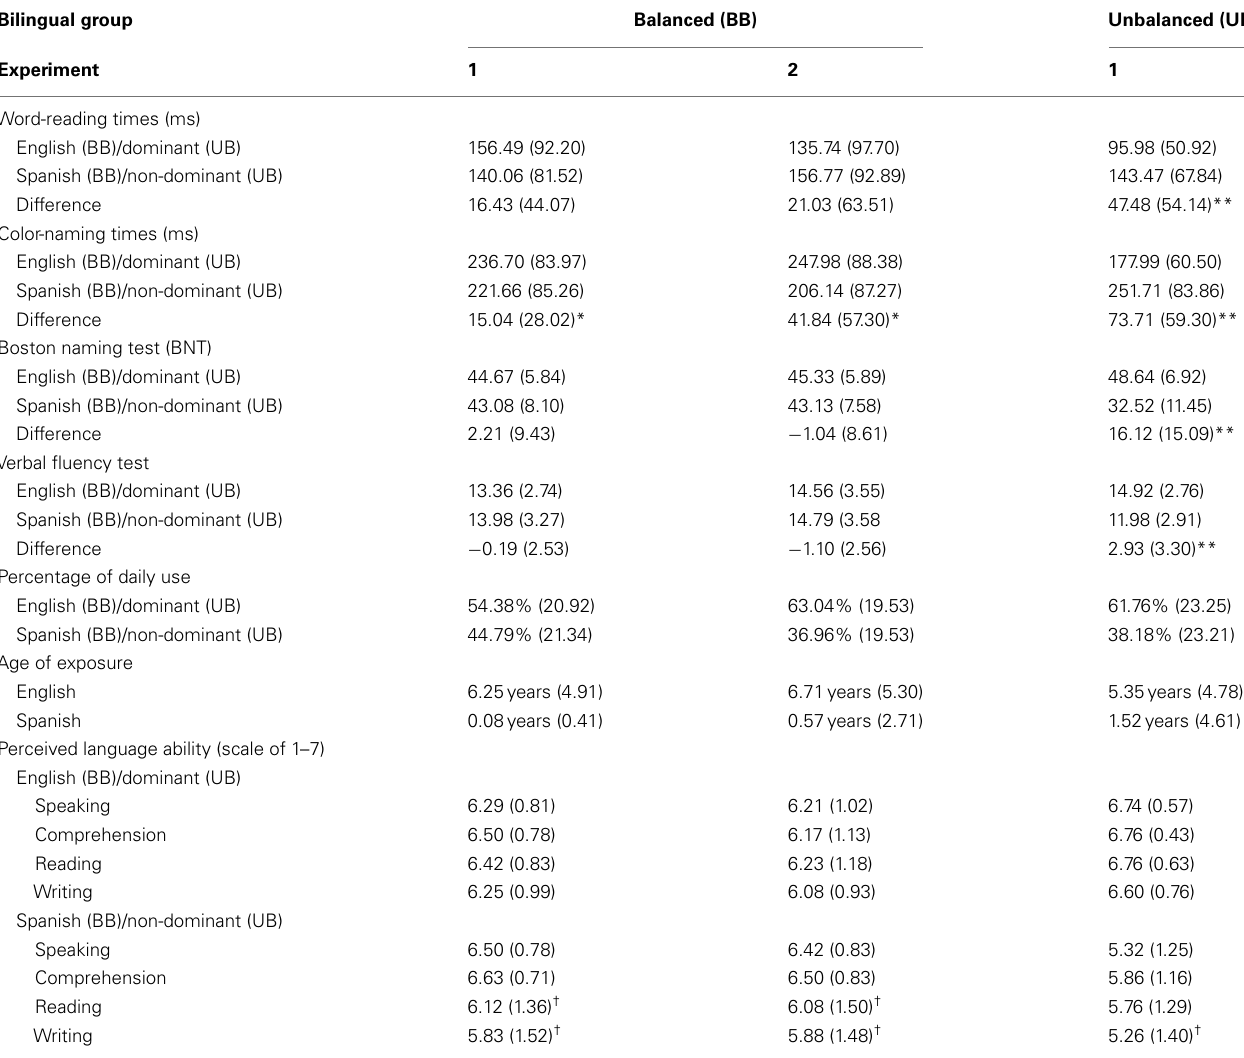
Table 1 | Language profile means (SD), for balanced (Experiments 1 and 2, N = 24) and unbalanced (Experiment 1, N = 50)